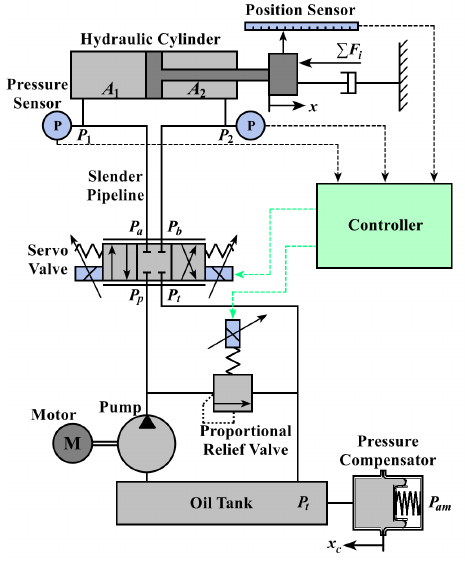
Figure 1. Schematic diagram of a deep-sea